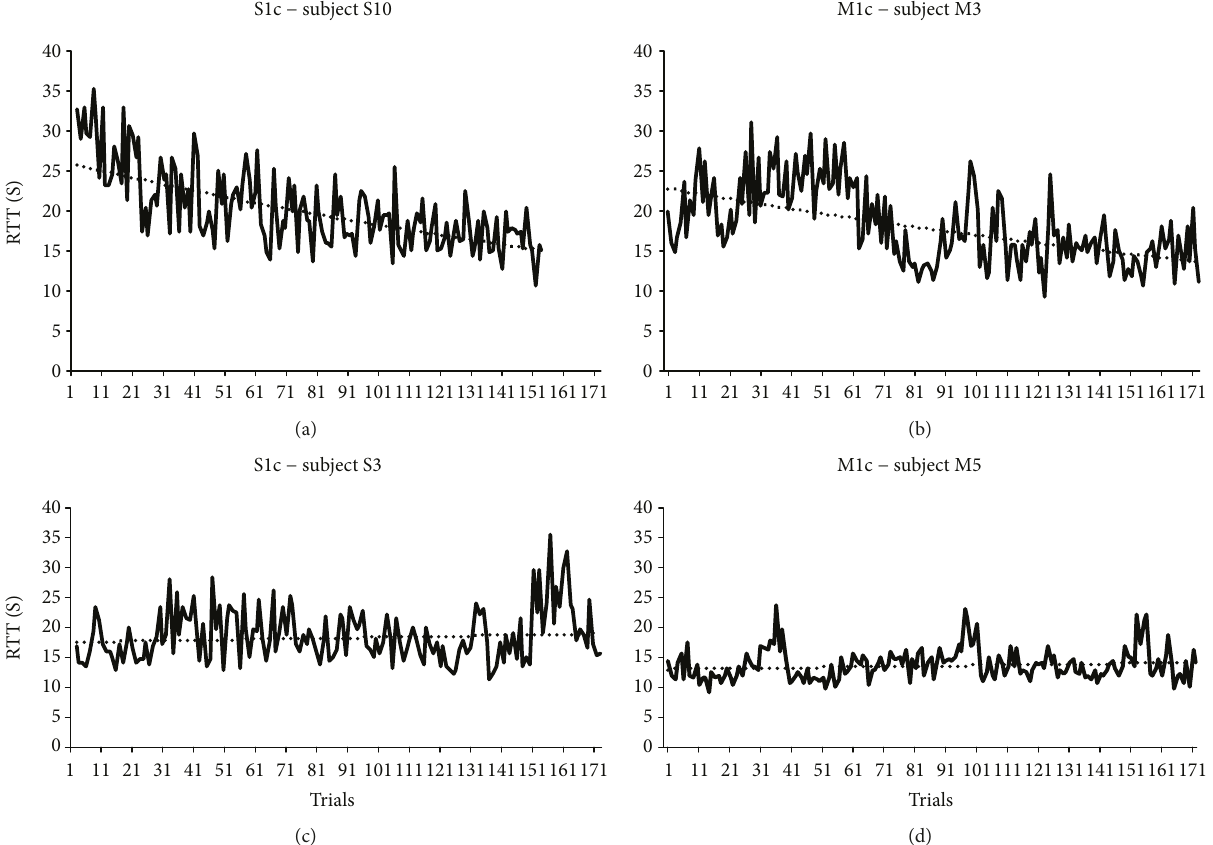
Figure 3: (a, b, c, and d) Active cTBS motor practice responder and nonresponders. The top panel represents motor practice responders (positive B score) following contralesional cTBS, delivered over the primary somatosensory cortex (S1c; Bscore = 14 27 ; (a)) or primary motor cortex (M1c; B score = 12 30 ; (b)), paired with motor skill practice. The bottom panel represents motor practice nonresponders (negative b score) following contralesional cTBS, delivered over the primary somatosensory cortex (S1c; B score = − 4 35 ; (c)) or primary motor cortex (M1c; B score = − 1 76 ; (d)) paired with motor skill practice. Table 3: Participant characteristics for motor practice responders and nonresponders in M1c, S1c, and sham groups. Group